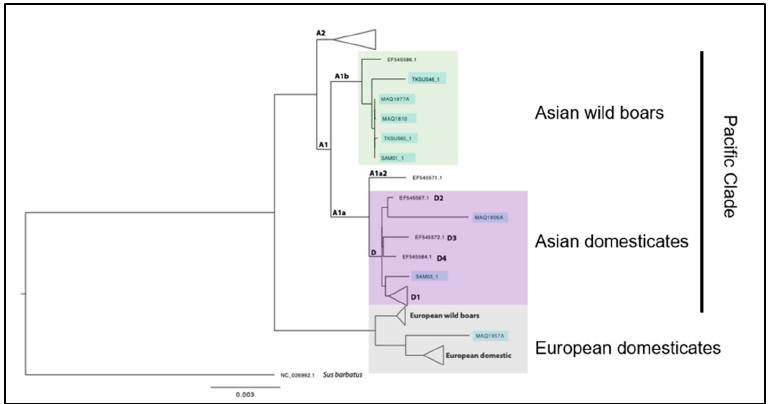
Figure 2. Ancient mtDNA from domestic pigs in Polynesia. We report the first whole genome mtDNA from pigs on Pacific Islands. Our results suggest all founding populations of pigs in Polynesia, first settled by people ca. 2800–700 BP, can be traced back to northern peninsular Southeast Asia. For simplicity, representative samples from GenBank and a sub-set of our results (8 out of 12 specimens) are shown on this phylogenetic tree.